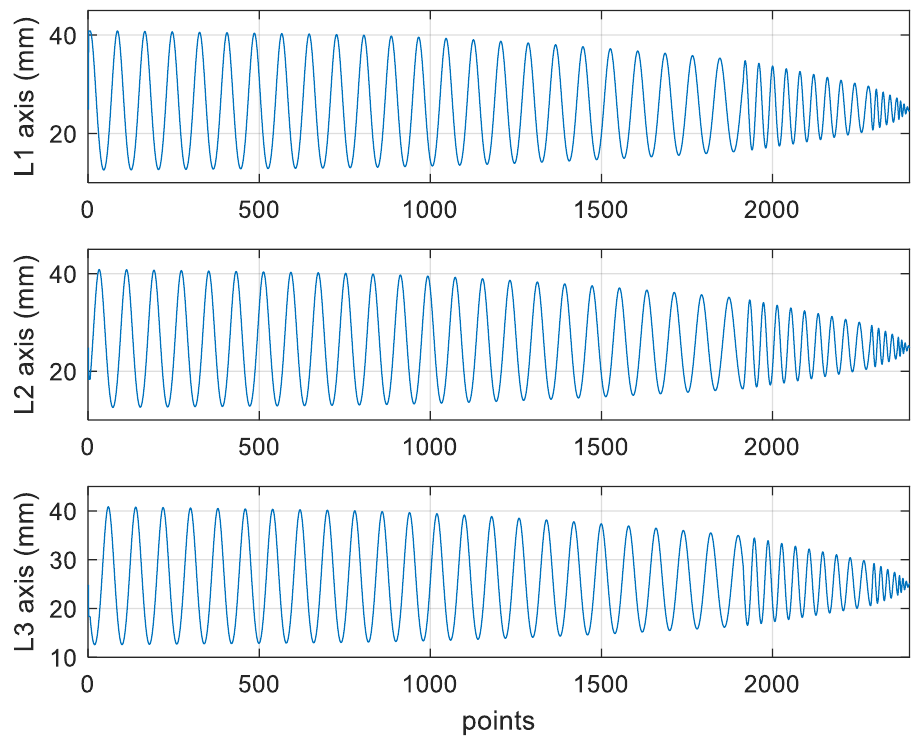
Figure 19. The lengths of the parallel three-axes after converting the rough machining program.